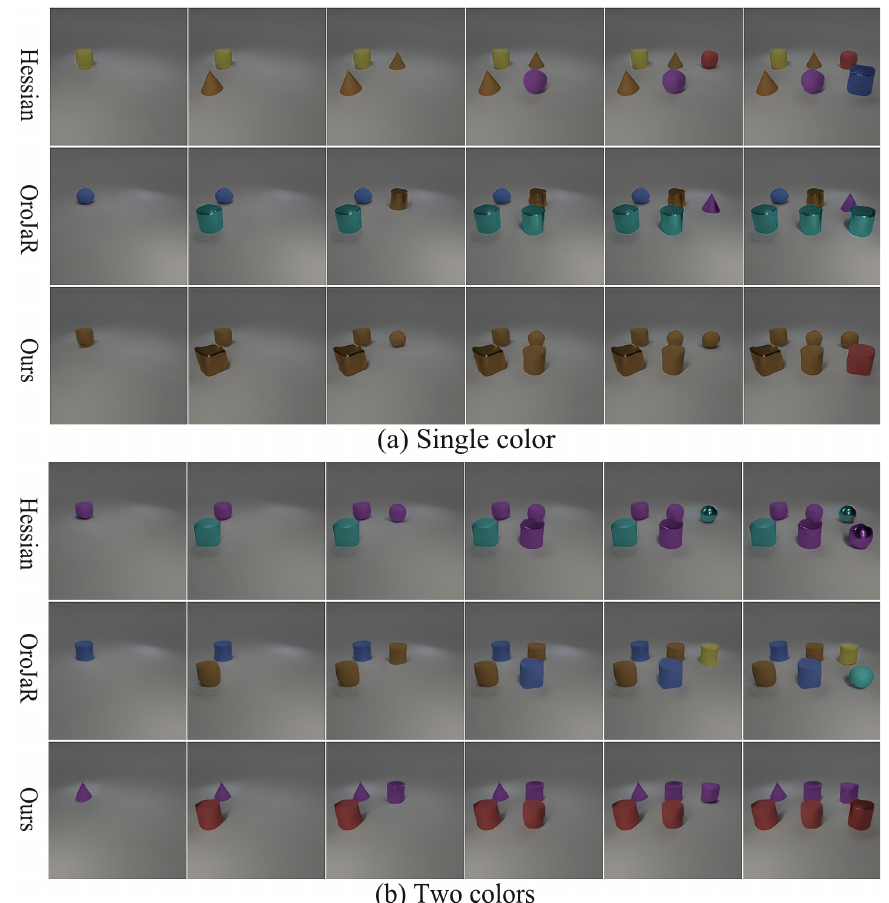
Figure 9. Comparison of disentanglement the quality of the CLEVR dataset by our method, Hessian penalty [13] and OroJaR [14] for adding